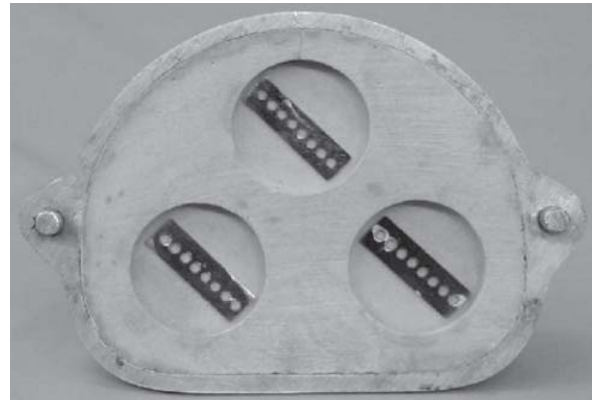
FIGURE 1- Position of Co-Cr metal bars in the mold cavities